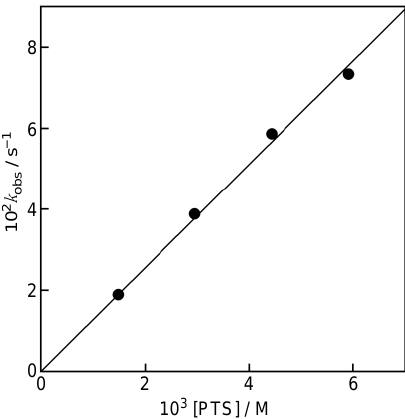
Figure 4. Plots of k obs vs. concentrations of PTS.